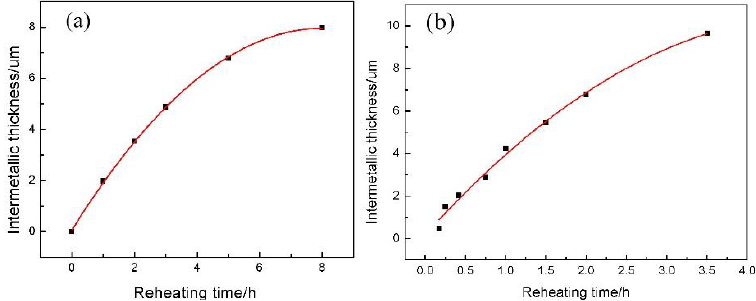
Figure 18. ( a ) An evolution of the average total intermetallic sample thickness during the remelting process; ( b ) A reaction layer thickness dependent on the heating time after heating for 10 min at 640 °C.